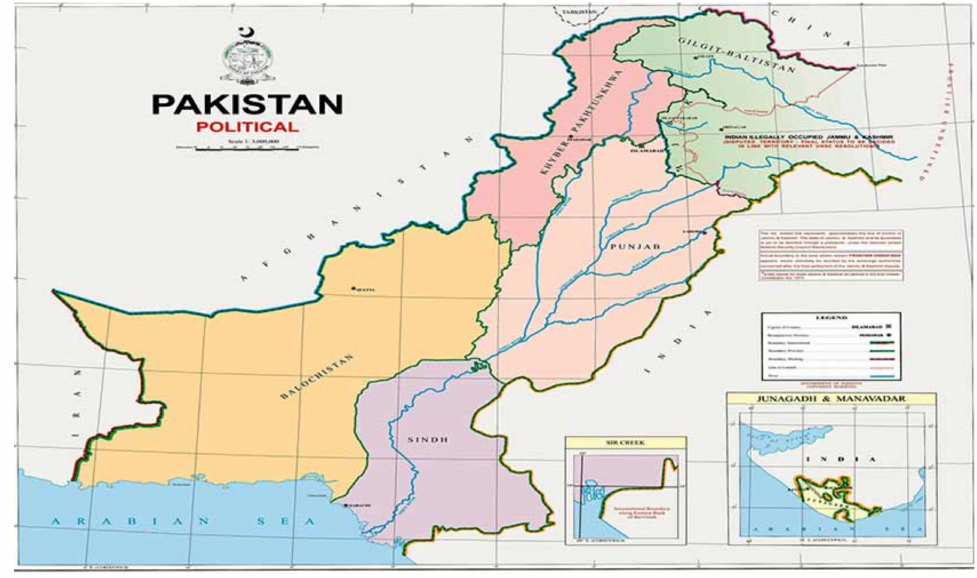
Figure 1. Map of Pakistan [1].